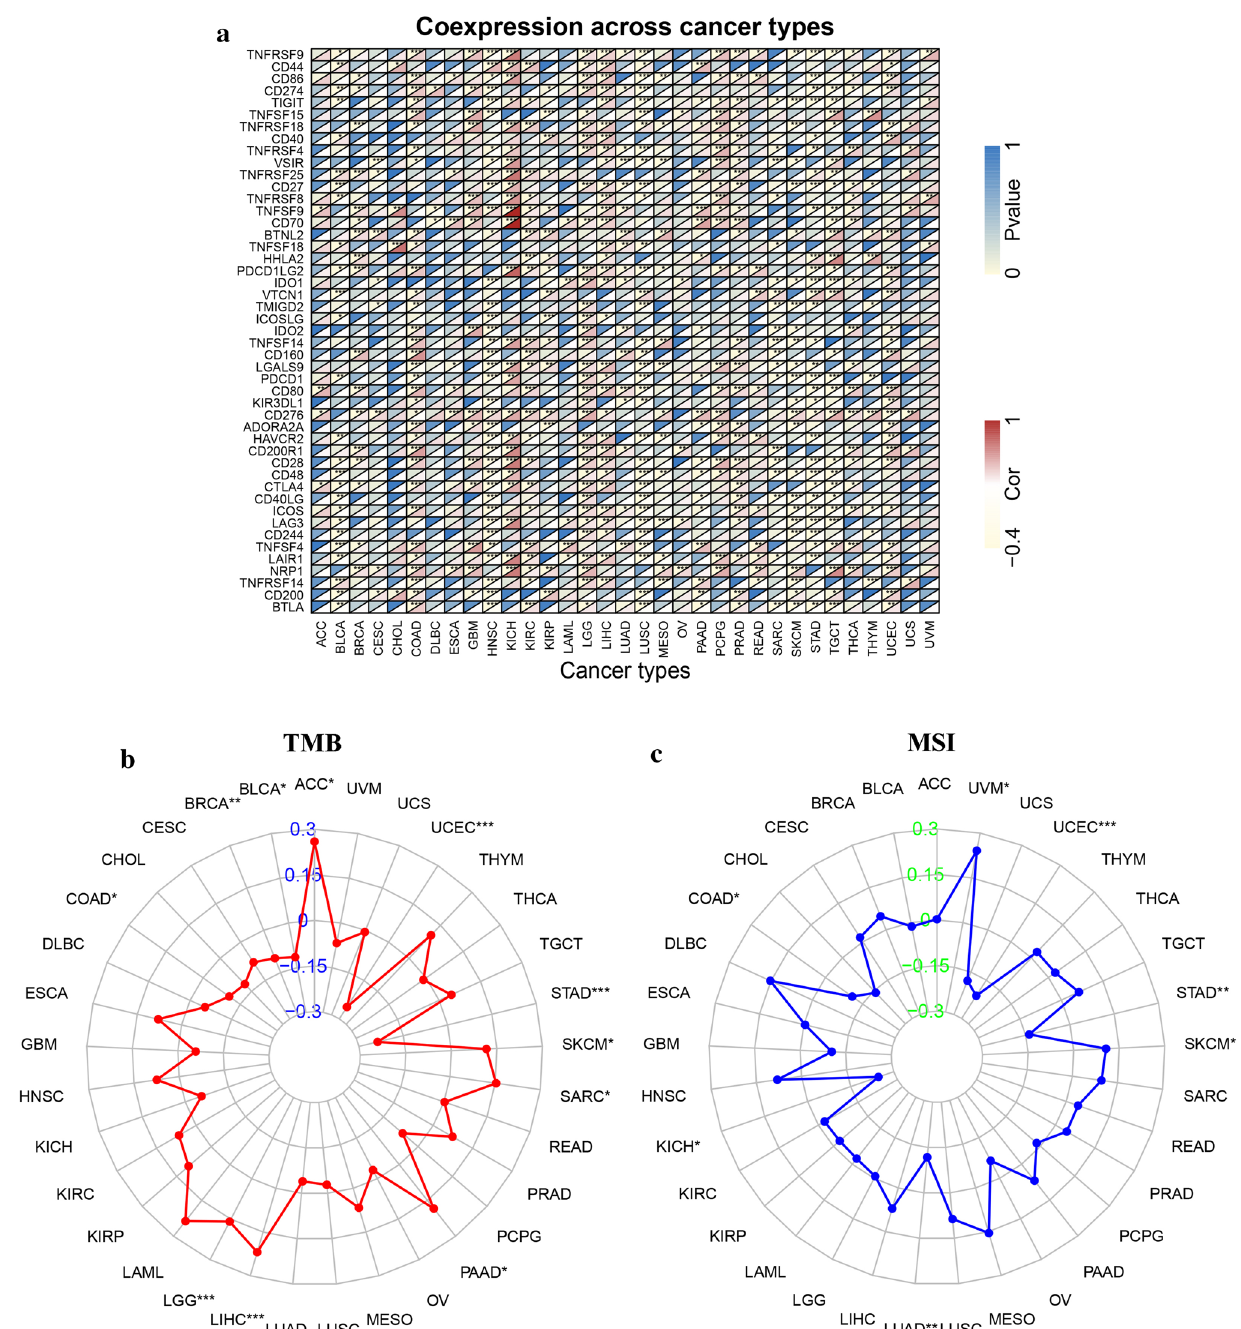
Fig. 7 The relationship between ZFPM2-AS1 expression and immune-related factors, TMB, and MSI in pan-cancers. a The relationship between ZFPM2-AS1 expression and immune-related factors. b The relationship between ZFPM2-AS1 expression and TMB. c The relation- ship between ZFPM2-AS1 expression and MSI. *P < 0.05, **P < 0.01, ***P <